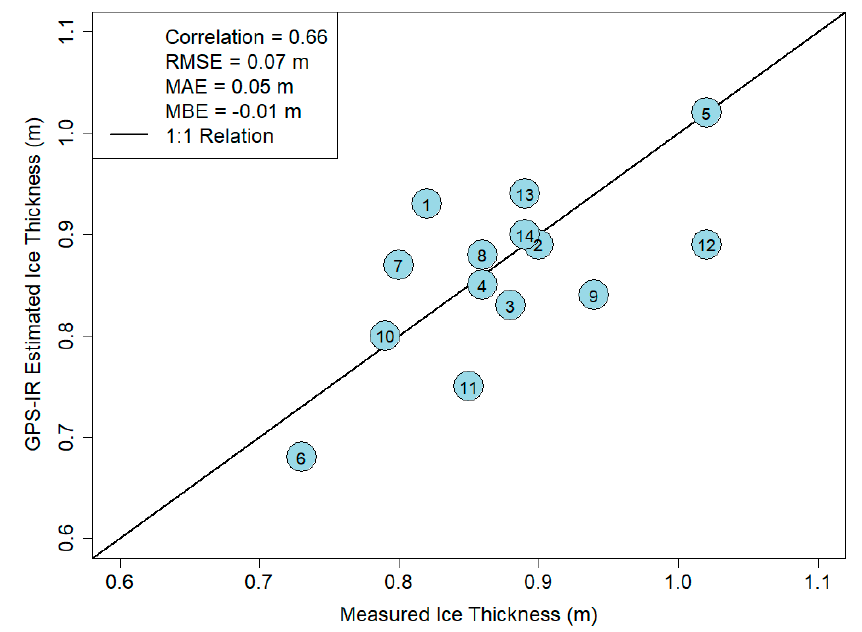
Figure 6. Correlation between in-situ measurements and GPS-IR retrievals.